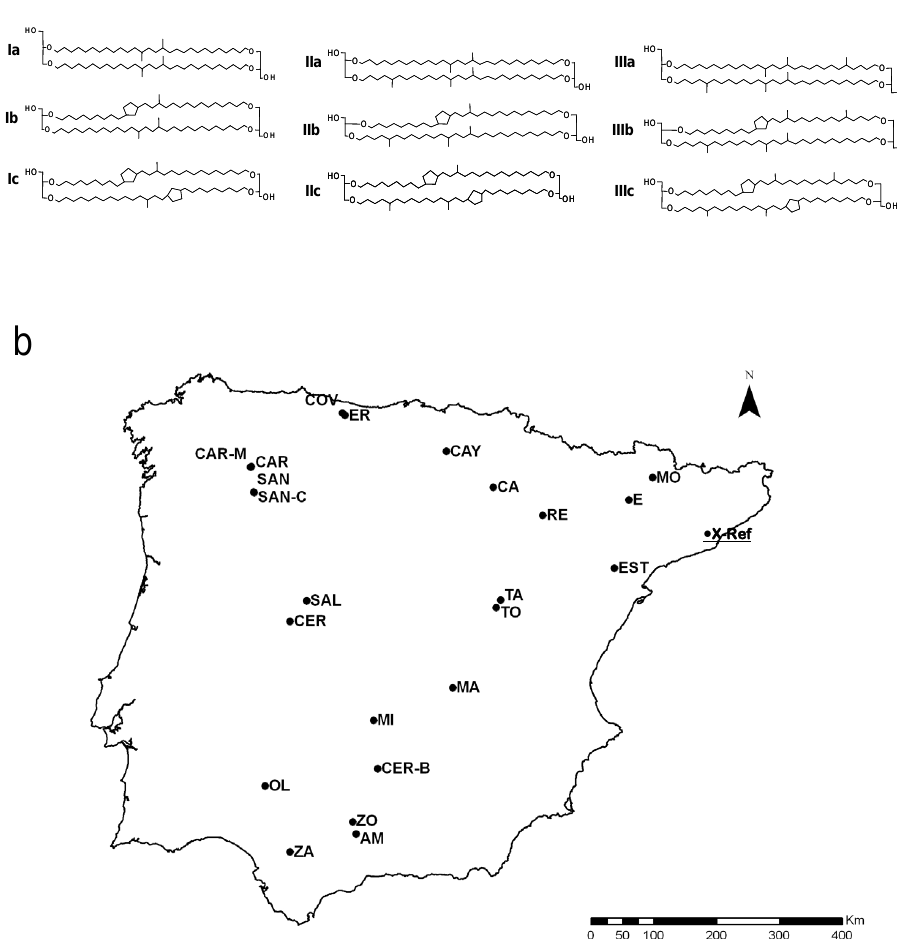
Fig. 1. (a) Chemical structures of brGDGTs discussed in the text, (b) map of the study area with locations of surface soils and sample codes used in this study; standard soil sample X-Ref appears